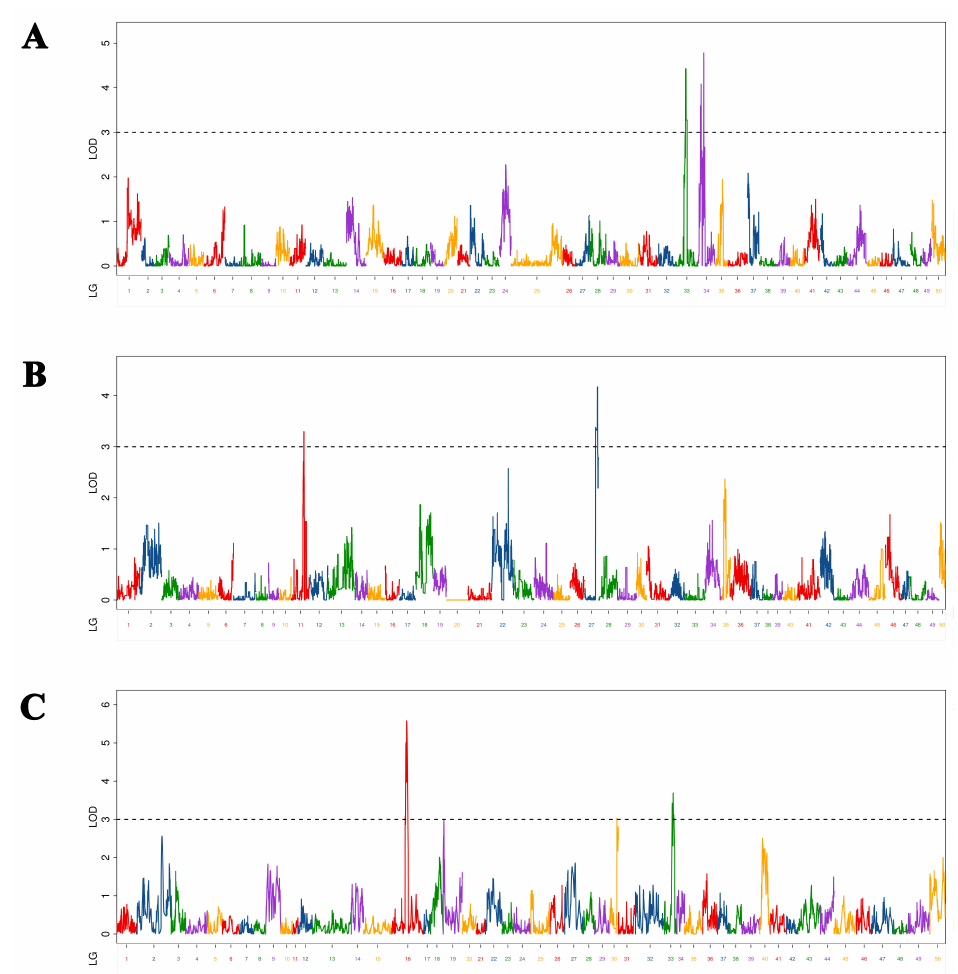
Figure 4. Distribution of body weight-related QTLs on 50 linkage groups of Yellow River carp in the maternal ( A ), paternal ( B ), and HH maps ( C ). Different color indicates different linkage